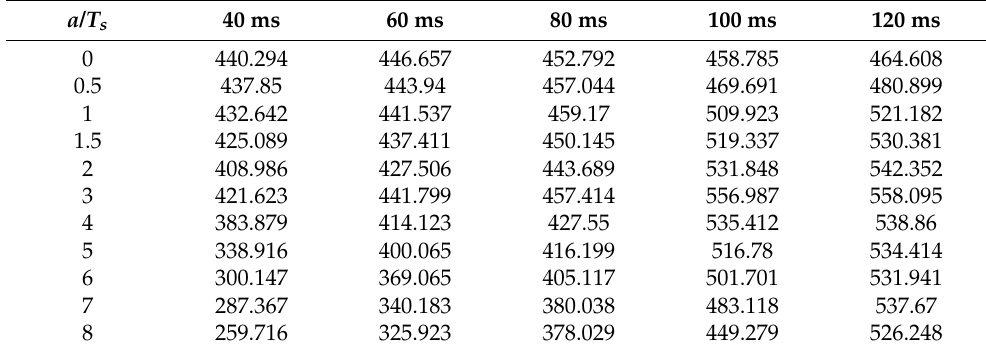
Figure 7. Luminance values when the EWD was driven by different a values and T s values. The maximum luminance value could be obtained when a was set to 3 and T s was set to 100 ms. Table 2. Luminance values when the EWD was driven by different a values and T s